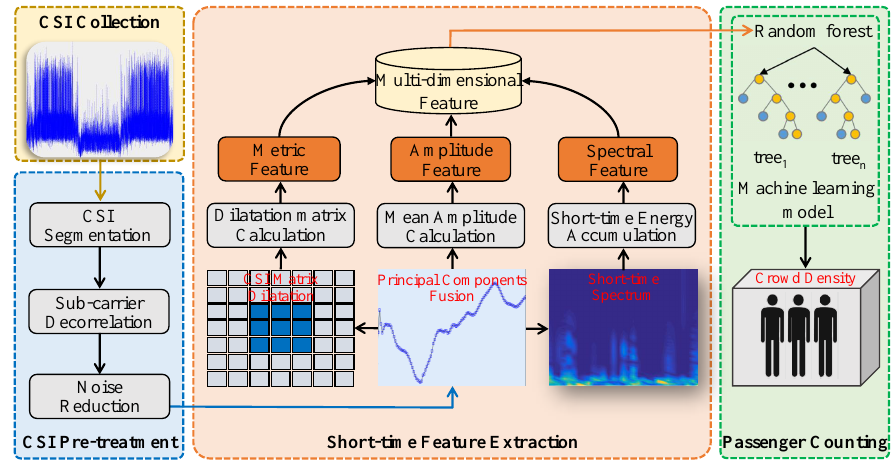
Figure 2. The work flow.